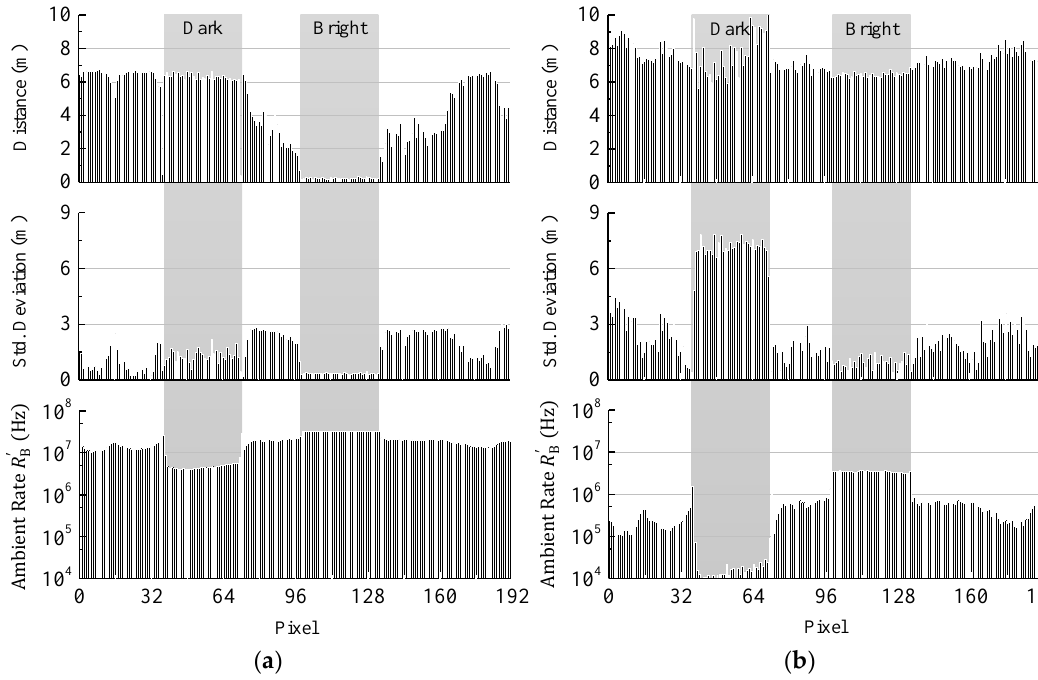
Figure 12. ( a ) Measured mean distance, standard deviation, and ambient event rate for low ambient light rejection. While the dark target can be measured properly, the received event rate of the bright target is too high; ( b ) Same measurement for a high ambient light rejection. In this case the bright target can be measured while the dark one cannot.